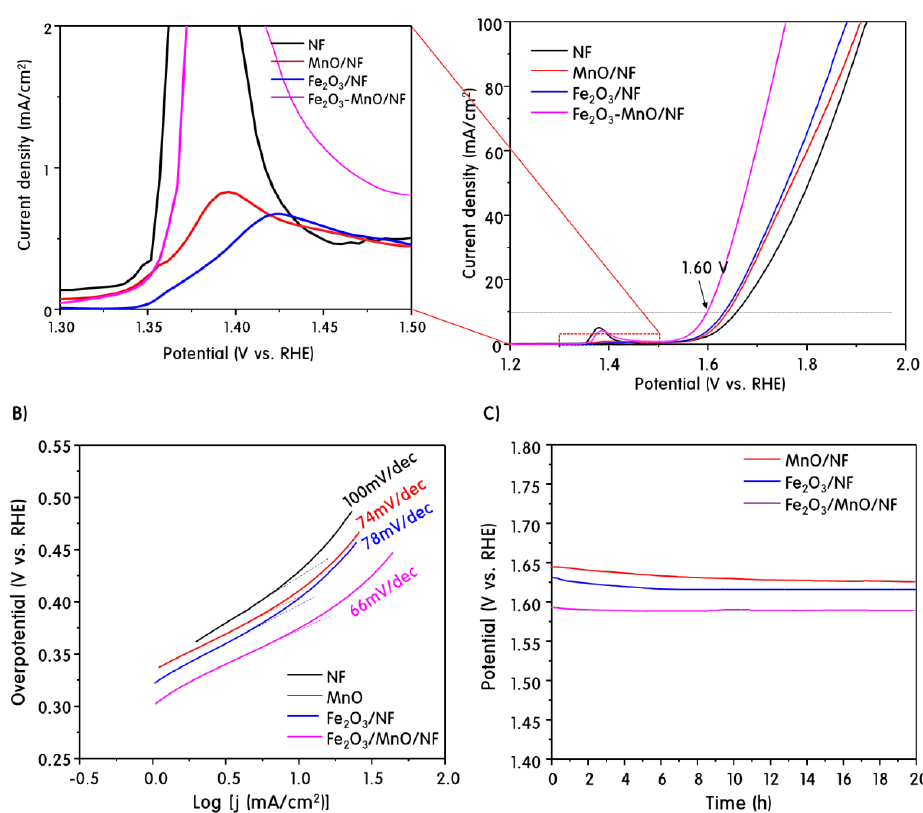
Figure 4. Linear sweep voltammetry (LSV) curves measured at the 100-cycle OER test ( A ), Tafel slopes derived from the LSV polarization curves ( B ), and chronopotentiometric curves of water electrolysis for different catalyst electrodes with a constant current density of 10 mA cm −2 ( C ).